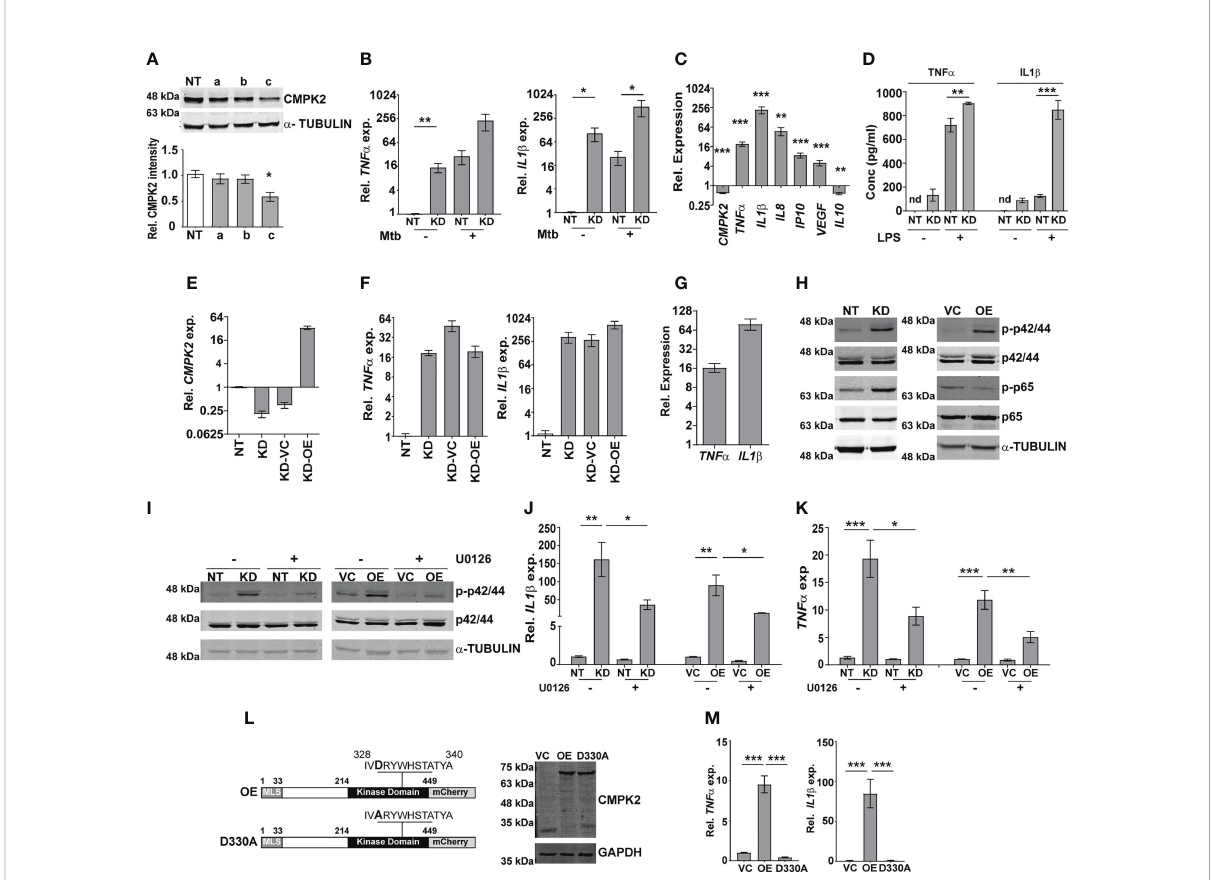
(D330A) as a kinase dead variant of CMPK2 (D330A) and analyzed the functional consequence of this expression on cytokine gene expression. Despite the strong and stable expression of D330A, comparable to the Wt, CMPK2 (OE),